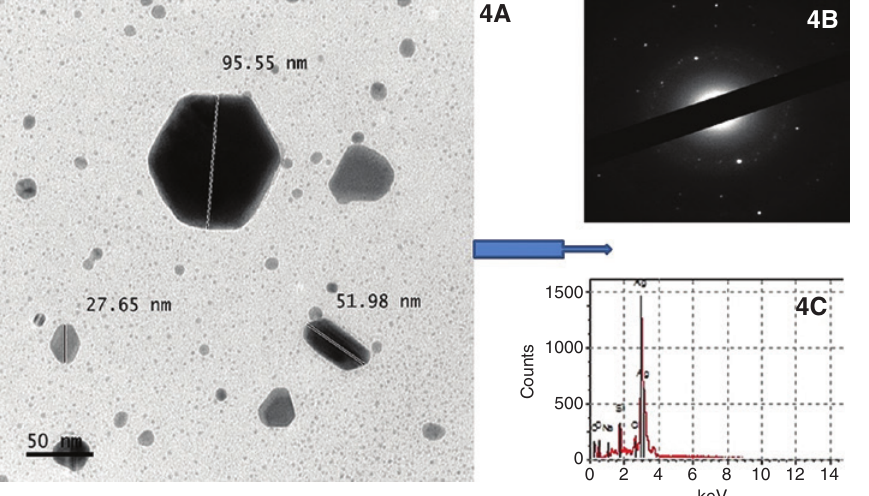
Figure 5: Transmission electron micrograph (A), SAED pattern (B), and EDX spectrum (C) of the biosynthesized AgNPs using nest extract of paper